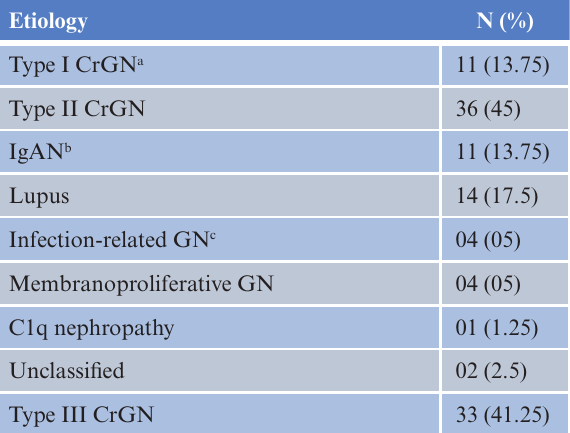
Table 1: Etiology of crescentic glomerulonephritis in our study